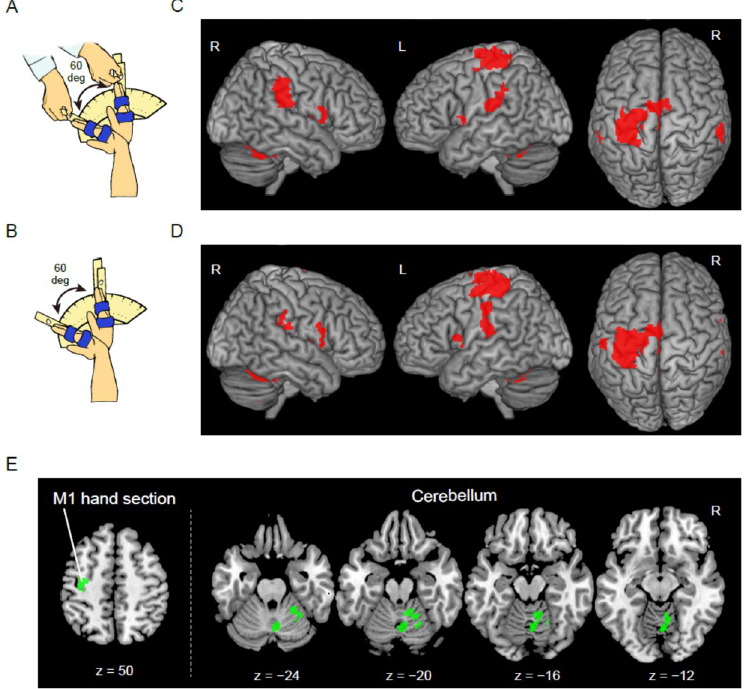
Figure 1. Functional magnetic resonance imaging (fMRI) tasks and results of the control group. ( A ) Passive task. ( B ) Active task. ( C ) Brain regions active during the passive task. ( D ) Brain regions active during the active task. These sections are superimposed on the MNI standard brain. The right hemisphere, left hemisphere, and the top view are shown in each panel. ( E ) Brain regions (M1 hand section and cerebellum) where the control group showed greater activity during the active than during the passive task. These regions are superimposed on the transverse slices (z = 50, −24, −20, −16, and −12) of the MNI standard brain. Abbreviations: R, right; L, left; M1, primary motor cortex; MNI, Montreal Neurological Institute.